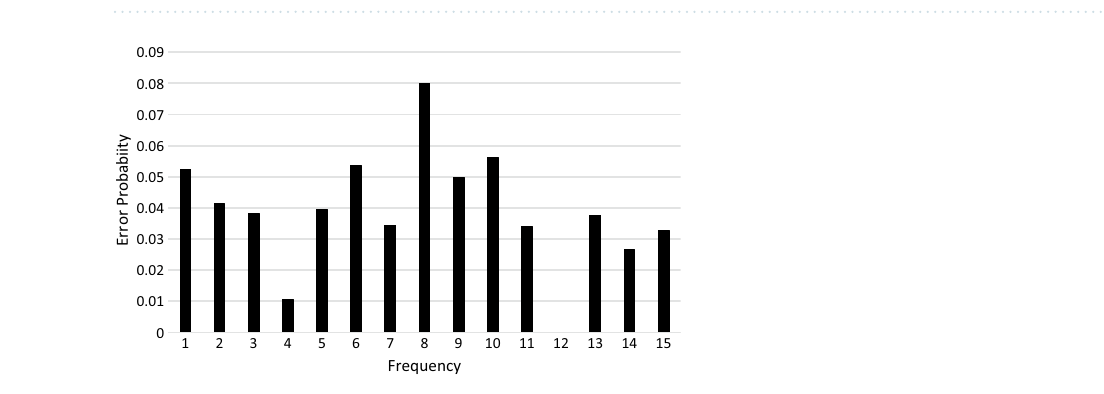
Figure 7. Calibration data. ( a ) Observed vs actual probabilities. ( b ) Spectral analysis of the observed probabilities when actual probabilities is zero.